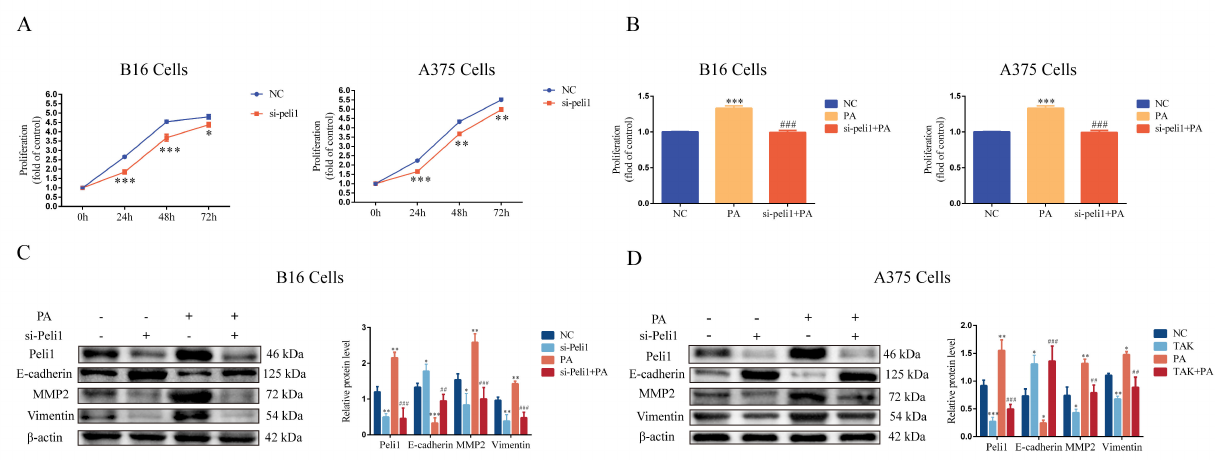
Figure 6. Inhibition of Peli1 expression blocked PA-induced cell proliferation and changed the expression of EMT-related proteins in the B16 and A375 cells. ( A ) The level of cell proliferation after si-Peli1 in B16 and A375 cells. ( B ) The level of cell proliferation after B16 and A375 cells were incubated with si-Peli1 and/or PA for 24 h. ( C ) Protein levels and quantitative analysis of Peli1, E-cadherin, MMP2, and Vimentin in B16 cells incubated with si-Peli1 and/or PA for 24 h. ( D ) Protein levels and quantitative analysis of Peli1, E-cadherin, MMP2, and Vimentin in A375 cells incubated with si-Peli1 and/or PA for 24 h. In A375 and B16 cells, treatment with PA or si-Peli1 (+) and no treatment with PA or si-Peli1 (-). * p < 0.05, ** p < 0.01, or ***p < 0.001 compared with the control group. ## p < 0.01, or ### p < 0.001 compared with the PA group; the significance of the